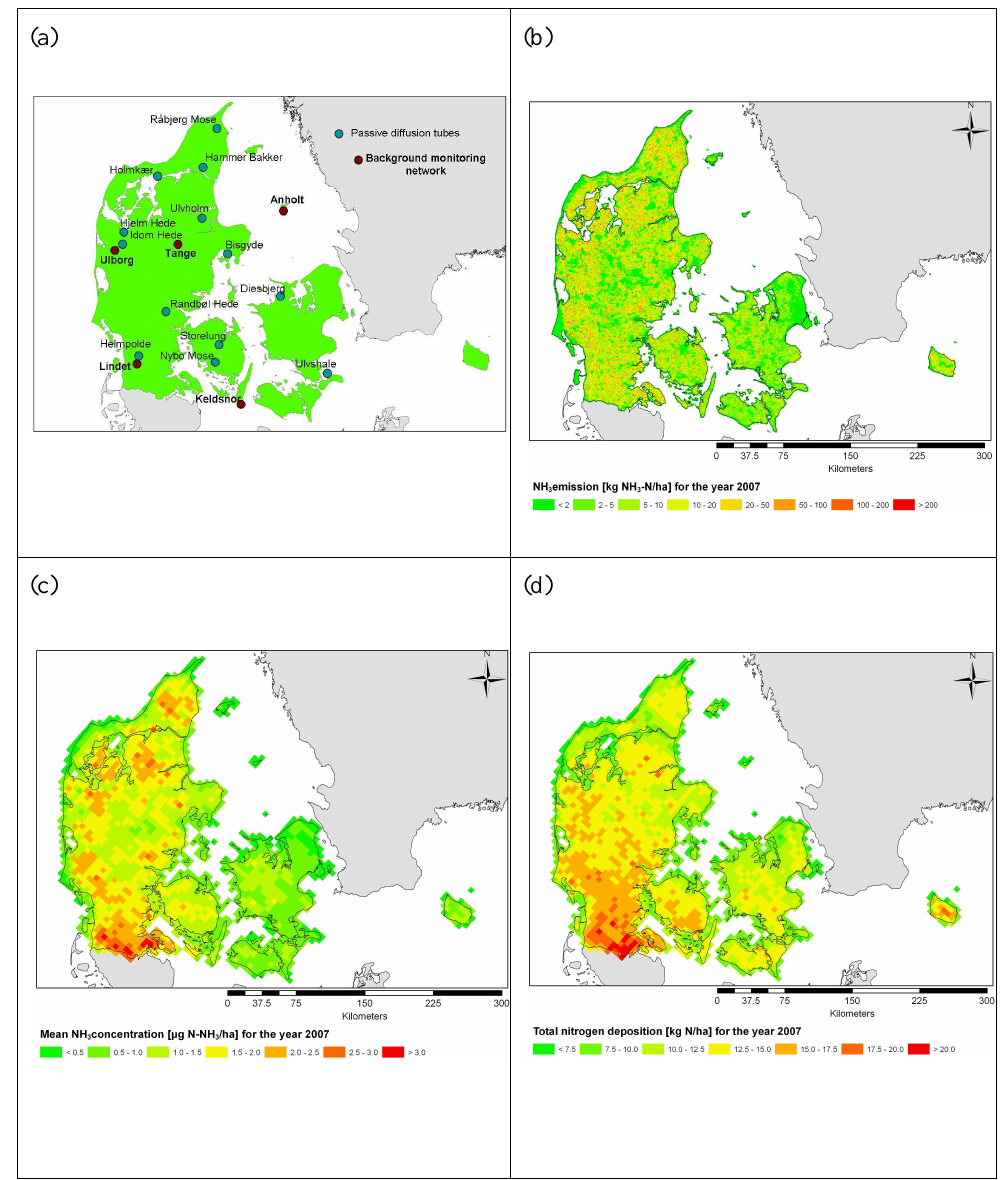
Fig. 1. (a) The locations of the measuring sites included in this study. (b) An example of the distribution of NH 3 emissions across Denmark on a 1km × 1km grid for the year 2007. (c) The yearly averaged NH 3 concentration over Denmark as calculated by the DEHM model for the year 2007. (d) The yearly total nitrogen load over Denmark as calculated by the DEHM model for the year